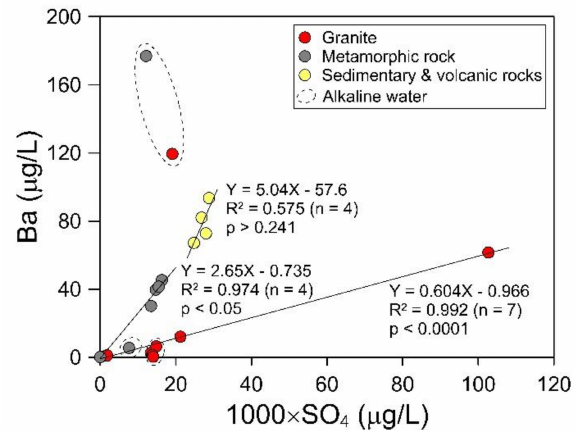
Figure 5. Plot of Ba and SO 4 for FW samples corresponding to particular lithology. The water samples derived from granitic and metamorphic rocks are represented by regression lines with high correlations.